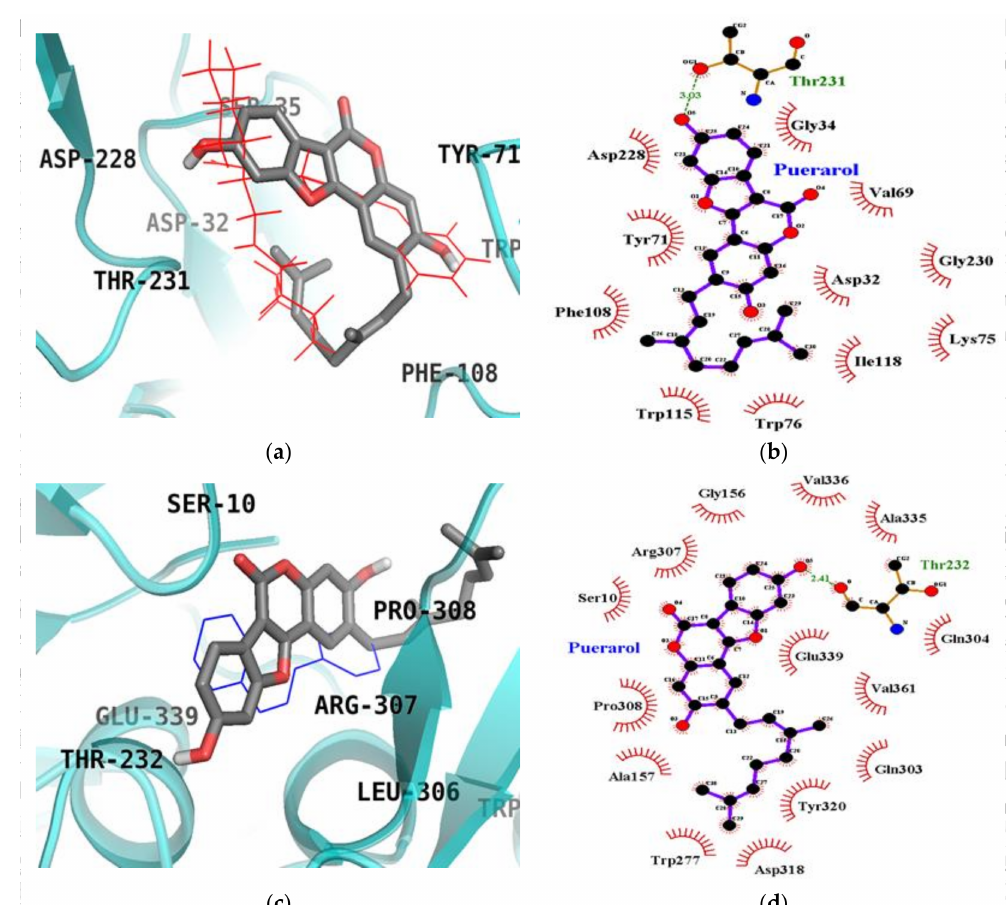
Figure 7. Inhibition mode of puerarol for the BACE1 catalytic site ( a ) with QUD (red line) and allosteric site ( c ) with TMF (blue line). 2D ligand interaction diagram of BACE1 catalytic ( b ) and allosteric ( d ) inhibition by puerarol. Dashed lines indicate H-bonds. Carbons are in black, nitrogens in blue, and oxygens in